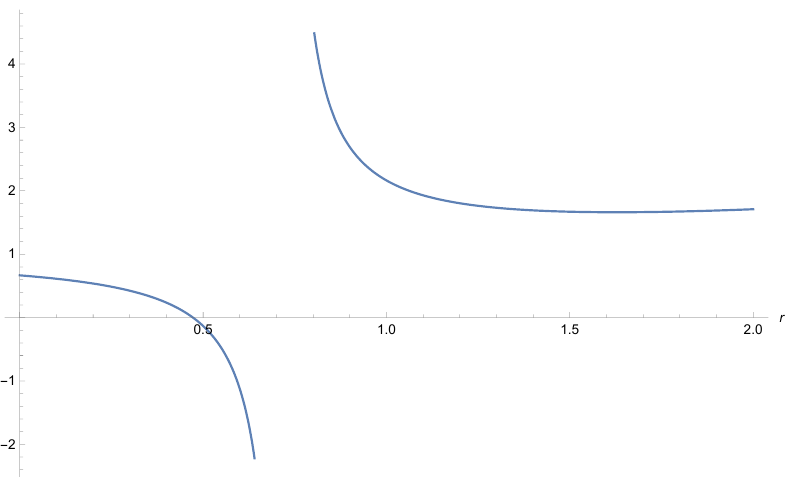
Figure 2. Plot of ω ( r ) for a zero-tidal Schwarzschild wormhole ( β = 0) using the Kretschmann scalar for anti-screening function with λ = 1( ξ =